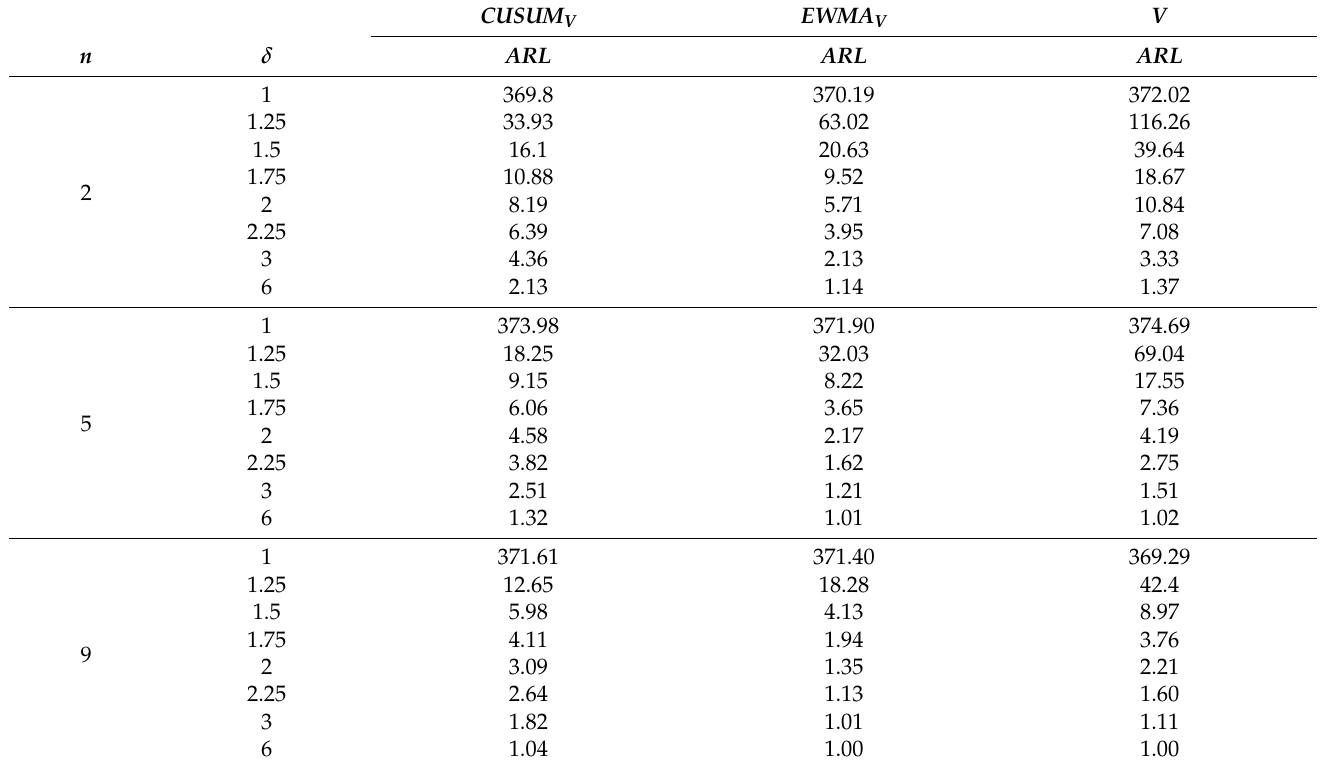
Table 5. ARL values of CUSUM V , EWMA V and V control